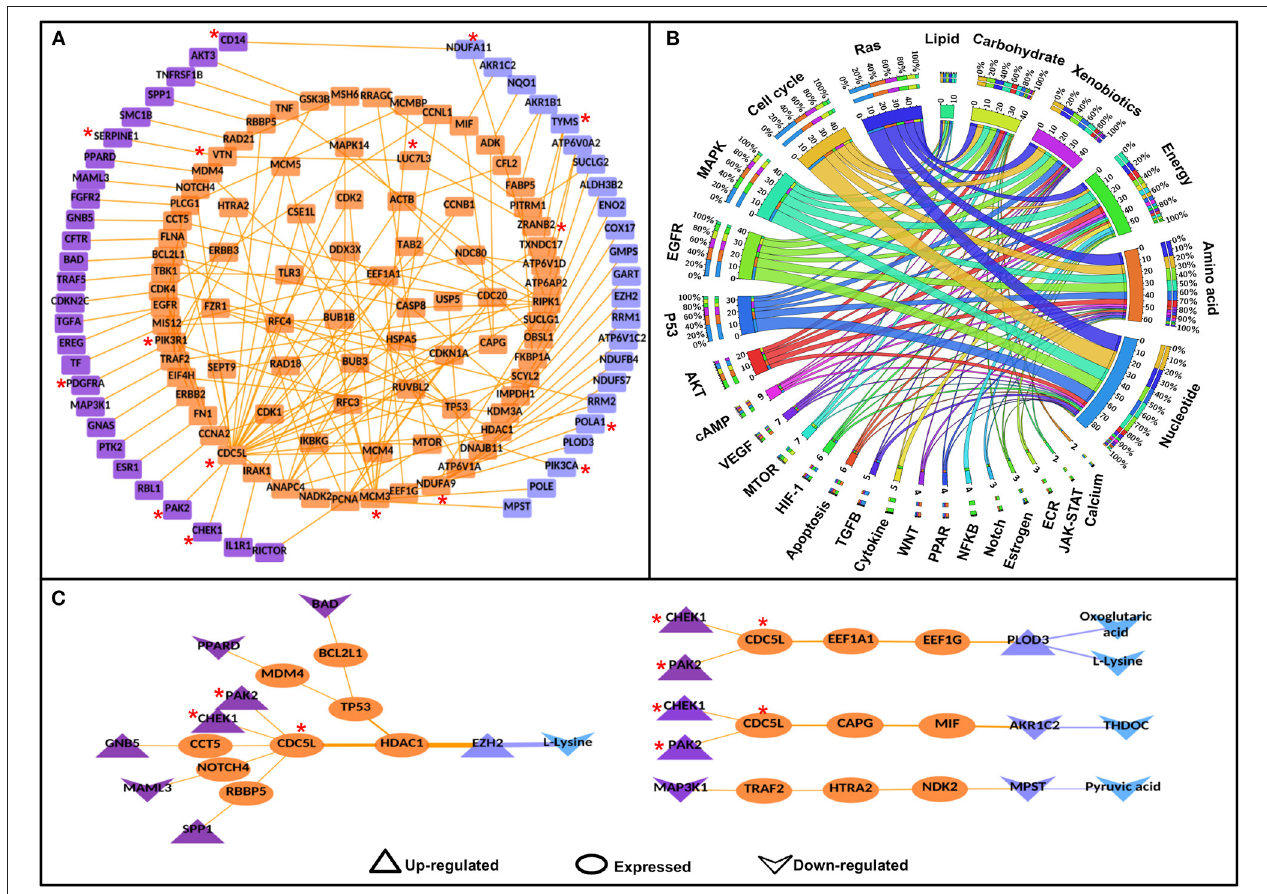
FIGURE 3 | Significant signaling-metabolic pathway interconnecting paths/network in cervical cancer. (A) represents a significant signaling metabolic interaction network, (B) shows the signaling metabolic pathways interconnectivity, and (C) shows the significant signaling to metabolic paths regulating metabolites in cervical cancer. Terminal signaling pathway proteins and metabolic enzymes are colored in purple and blue. Protein-protein interactors are colored in orange. Protein-protein interactions are represented by orange edges. Nodes with an asterisk (*) are key or effector nodes in the significant